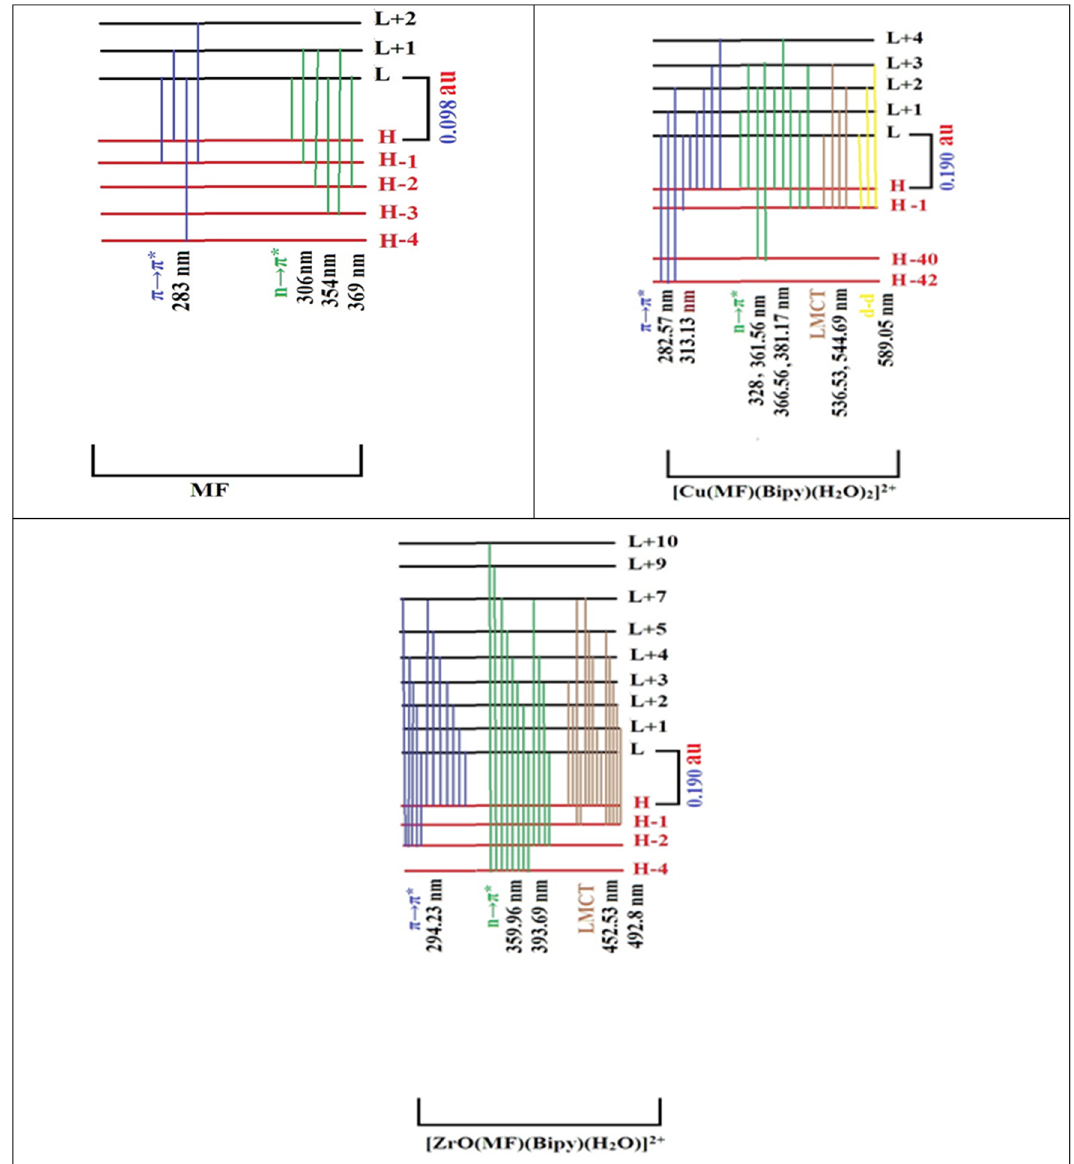
Figure 4. TD-DFT calculated electronic transitions in MF and their metal complexes by using DFT respectively, and L + 3 was localized on Cu(II) ion with 72%. These two excited states were equivalent to the experimental band at 290 nm, appointed to π → π* transition. The 2nd absorption band at 320 and 370 nm, which was established to n → π* transition, resulted from four theoretical bands at 328, 361.65, 366.56, and